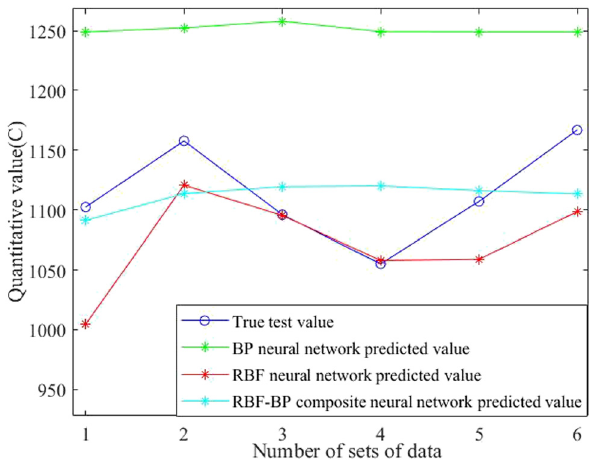
Figure 5: Predicted results of three neural networks against chloride ion penetration.